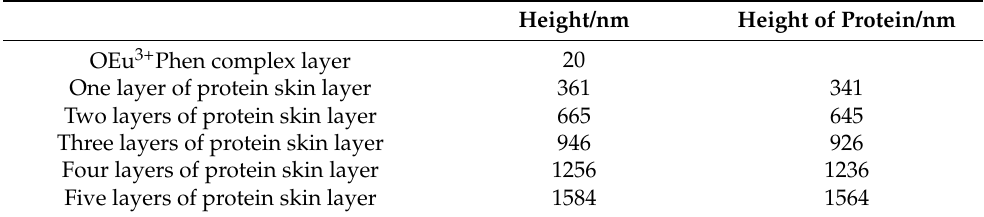
Figure 5. ( a ) AFM image of OEu 3+ Phen complex layer; ( b ) the local height in Figure a; ( c ) fluorescence intensity of 0 to 5 layers of protein; ( d ) the fluorescence lifetime curve of protein from 0 to 5 layers. Table 1. Height of 1–5 layers of protein skin layer.